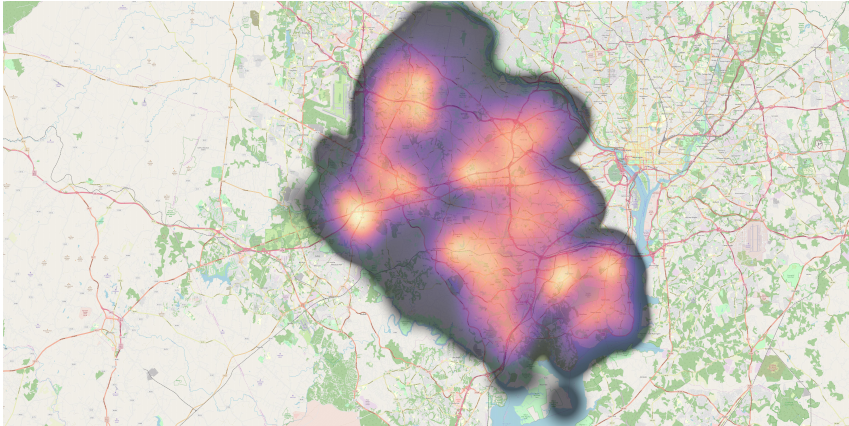
Figure 17. Heatmap analysis performed to designate regions with high density of